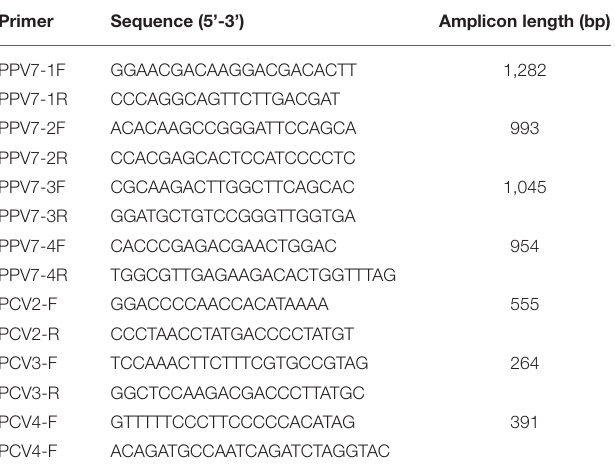
TABLE 1 | List of primers used in this study.